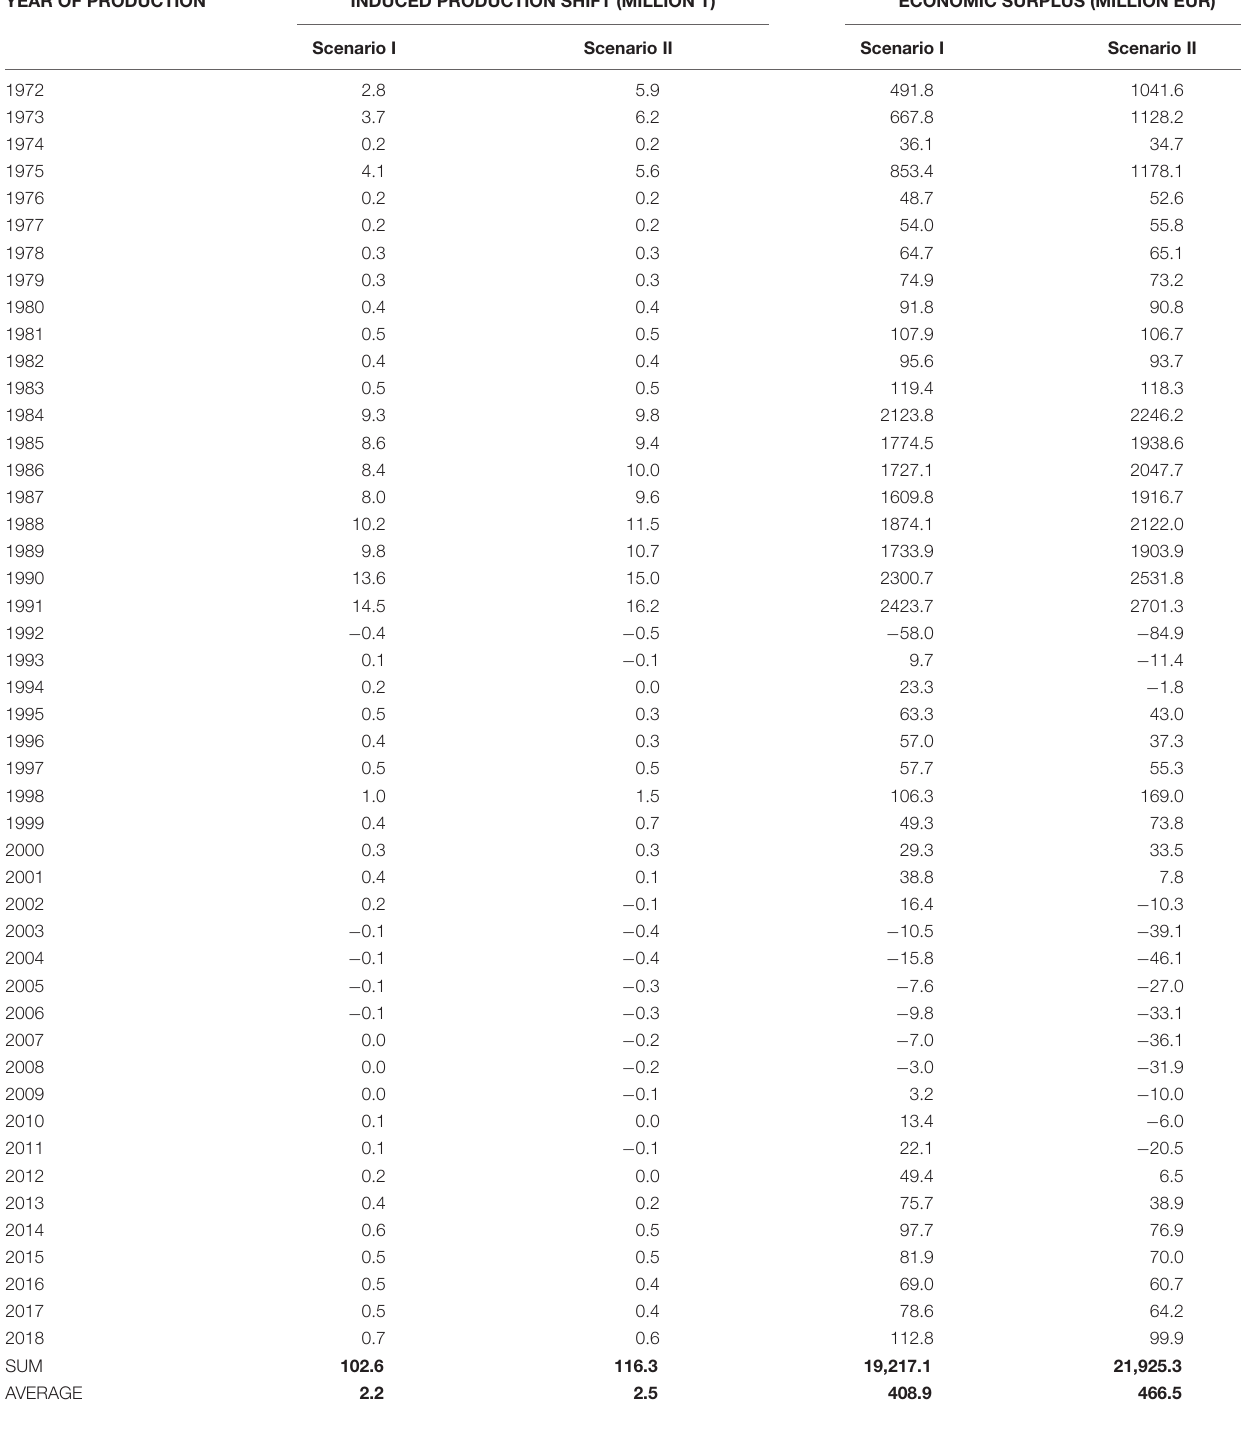
TABLE 5 | Scenario-induced production shifts and economic surplus over